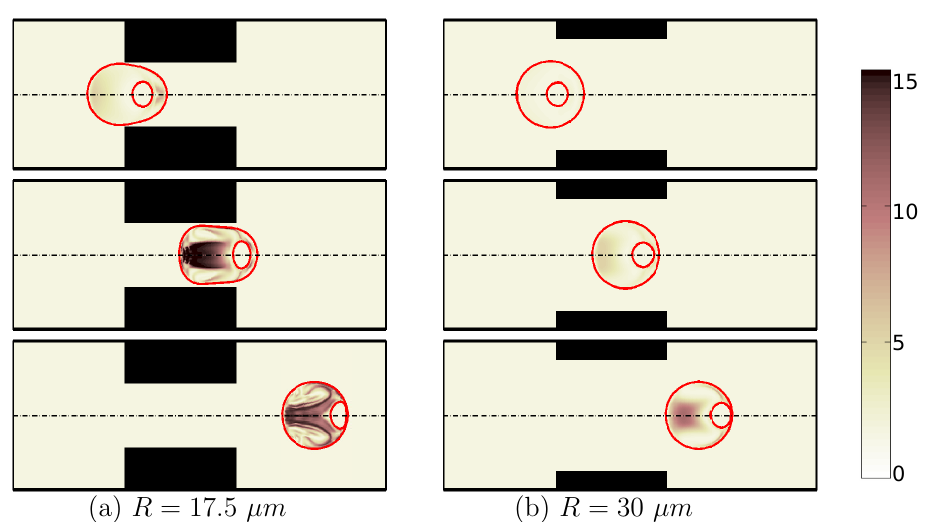
Figure 7. Shape evolution of an encapsulated HL60 cell through constricted microchannels with R = 17.5 µ m ( a ) and R = 30 µ m ( b ) at different locations of channel. The color bar and contours represent the square root of trace of conformation tensor inside the cell and the shell fluid. ( λ = 0.1 s, β = 0.5, Ca = 0.00076 and Re = 0.37).